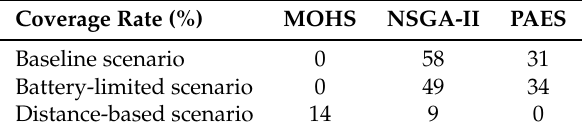
Table 4. Coverage Rate (%) per multi-objective approach and real use case